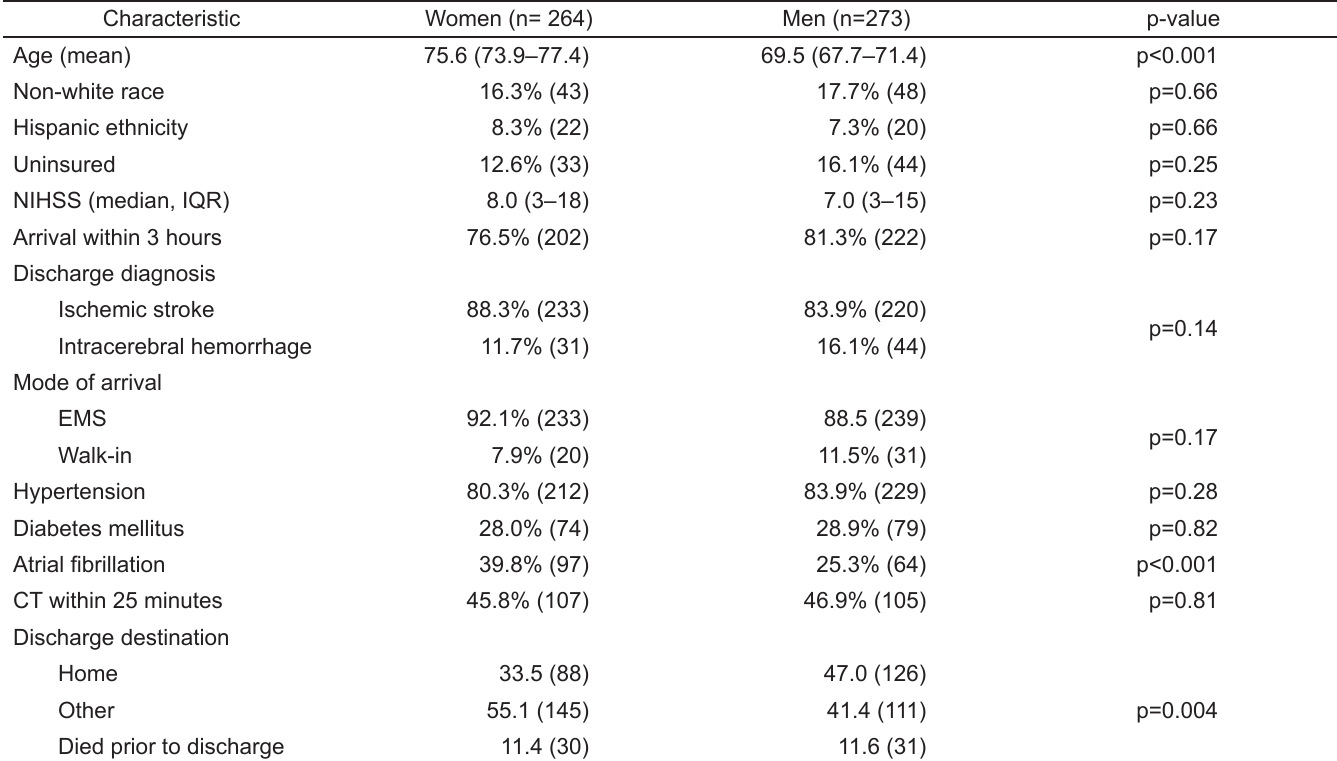
Table 1. Selected characteristics of participants, by